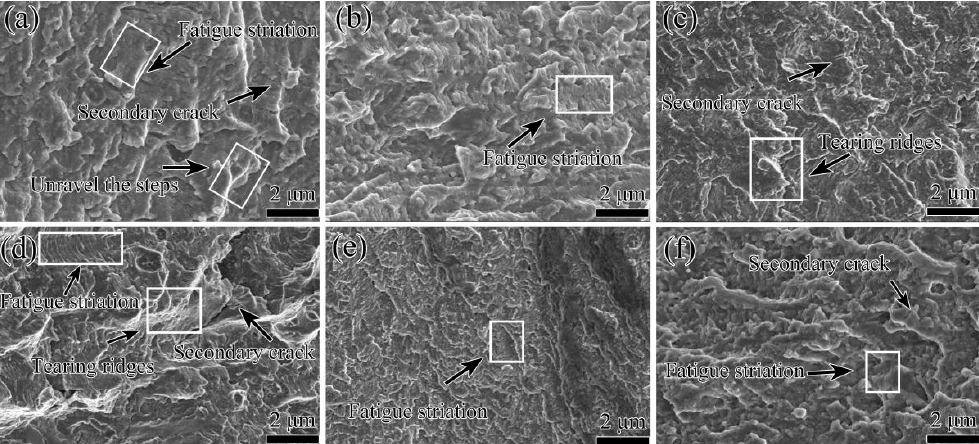
Figure 11. SEM images of fatigue fracture crack propagation in annealed 7005 aluminum alloy plates subjected to different pre-tensile deformations: ( a ) 3%, ( b ) 5%, ( c ) 8%, ( d ) 12%, ( e ) 16%, and ( f ) 20%.